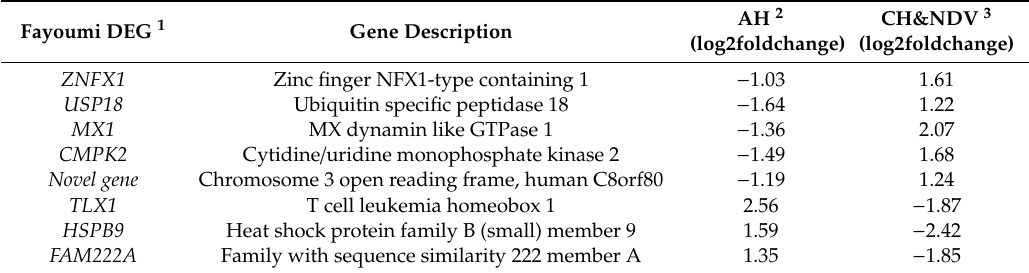
Figure 5. Venn diagram of differentially expressed genes within genetic lines. LTLCAH: Leghorn treated vs. non-treated with acute heat stress; FTFCAH: Fayoumi treated vs. non-treated with acute heat stress; LTLCCH: Leghorn treated vs. non-treated with chronic heat stress and 2 dpi NDV infection; FTFCCH: Fayoumi treated vs. non-treated with chronic heat stress and 2 dpi NDV infection. LTLCAH specific: specific DEGs in LTLCAH; FTFCAH specific: specific DEGs in LTLCAH; LTLCCH specific: specific DEGs in LTLCCH; FTFCCH specific: specific DEGs in FTFCCH. Table 2. Different gene expression regulation with the AH or CH&NDV treatment in Fayoumi birds.